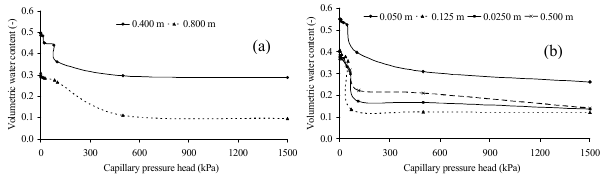
Fig. 6. Water retention characteristics of the (a) peat swamp forest and (b) dune forest sites.